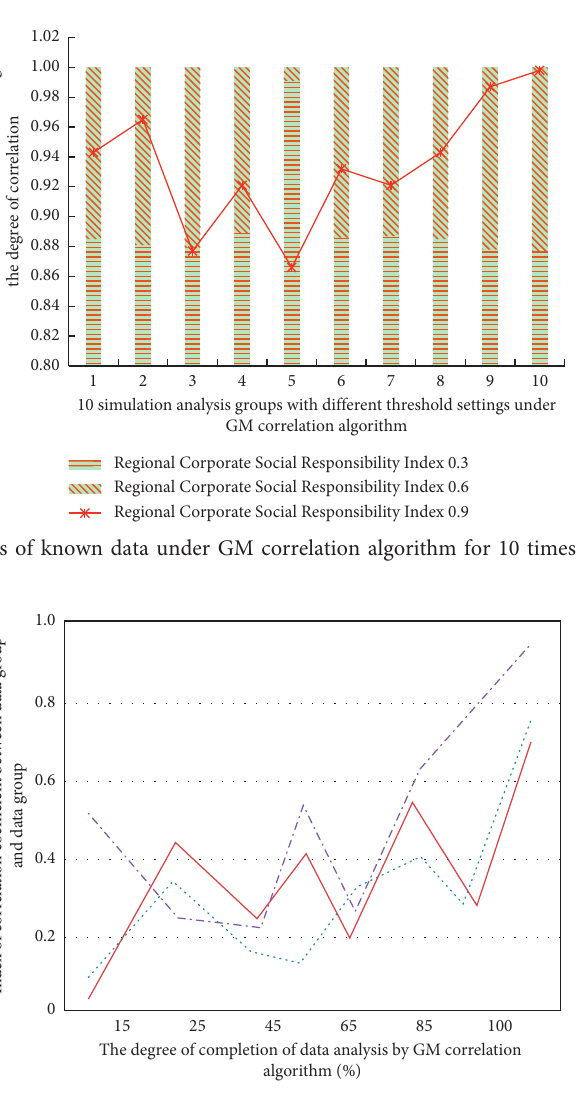
15 25 45 65 85 100 The degree of completion of data analysis by GM correlation algorithm (%)